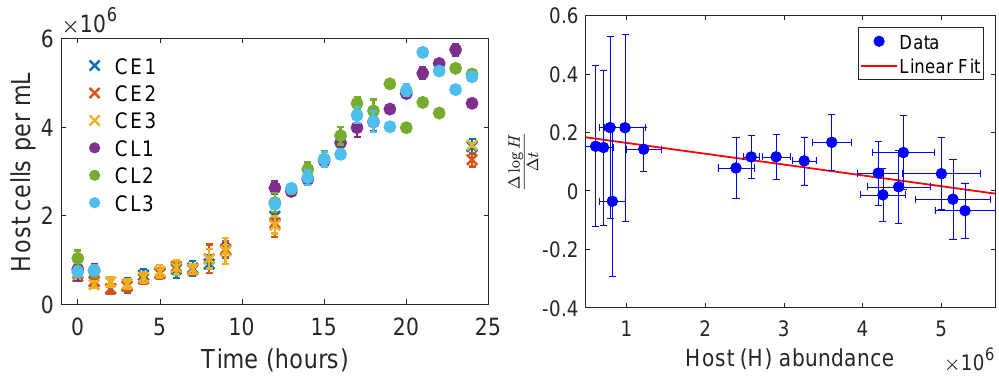
Figure 1. Cafeteria roenbergensis growth in the absence of CroV. ( Left ) Cell densities over time. The 24-h experiments were split into two 12-h periods of intense sampling for feasibility. Each color refers to a different set of replicates where CL refers to control–late and CE refers to control–early. The numbers refer to biological replicates. Samples for the “early” experiment occurred at {0,1,2,3,4,5,6,7,8,9,12,24} h and for the “late” experiment occurred at {0,1,12,13,14,15,16,17,18,19,20,21,22,23,24} h. ( Right ) Fitting a logistic growth model to host growth between sampled points. We average the abundances at each time point to reduce noise when fitting the